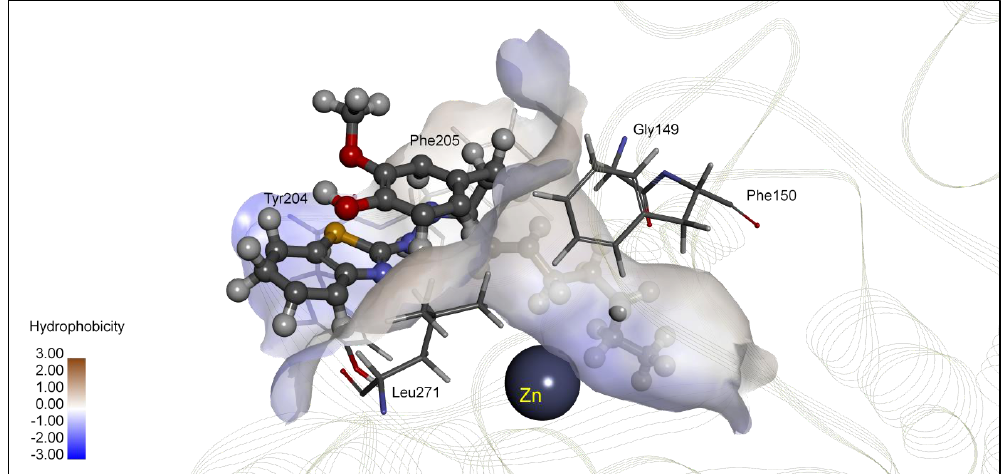
Figure 2. Interaction of 4d with HDAC1. Image was generated by DiscoveryStudio4.5.